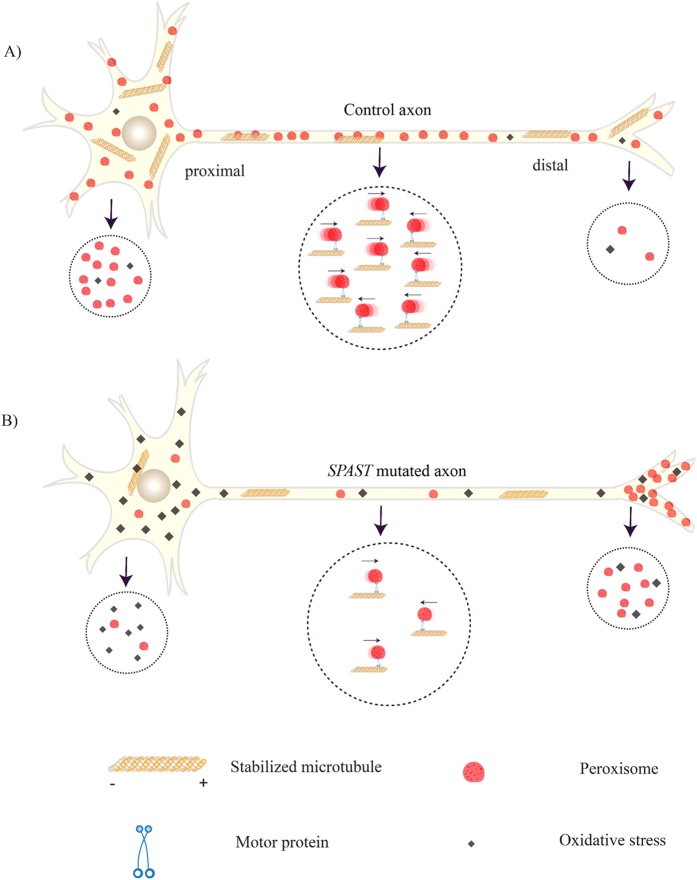
Model for oxidative stress linked to peroxisome trafficking.In healthy axons an adequate microtubule network allows normal numbers of peroxisomes to travel at normal speeds in anterograde and retrograde directions (A: large circle). In SPAST-mutated axons the reduced microtubule network reduces the number of peroxisomes causing fewer peroxisomes to travel more slowly, with a larger effect on retrograde transport (B: large circle). In healthy neurons the peroxisome transport is enough to assure normal peroxisome distributions in cell body and distal axon and appropriate redox state (A: small circles). In SPAST-mutated neurons impaired peroxisome transport causes a build-up of peroxisomes at the distal end of the axon, with reduced peroxisome turnover at the cell body leading to oxidative stress (B: small circles).